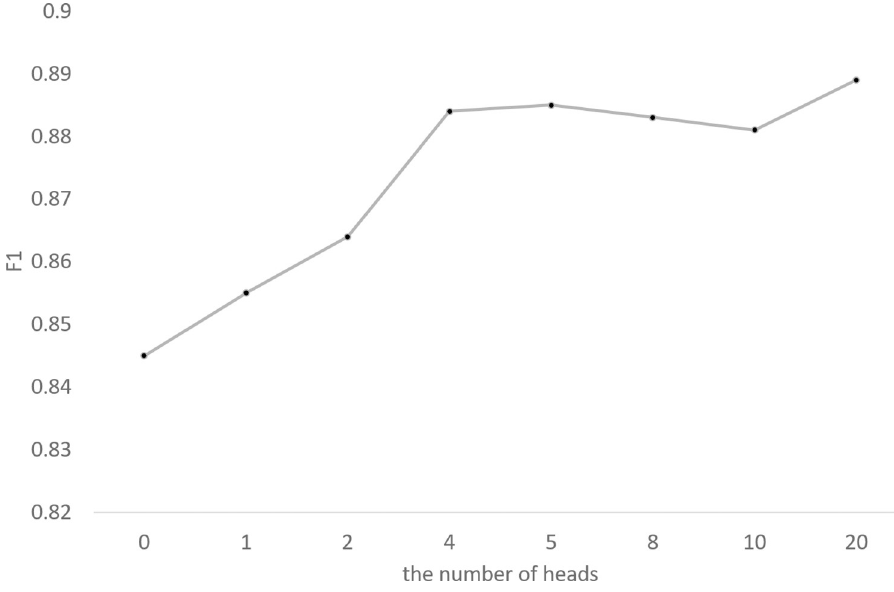
Fig 6. The F1 scores for different number of heads for